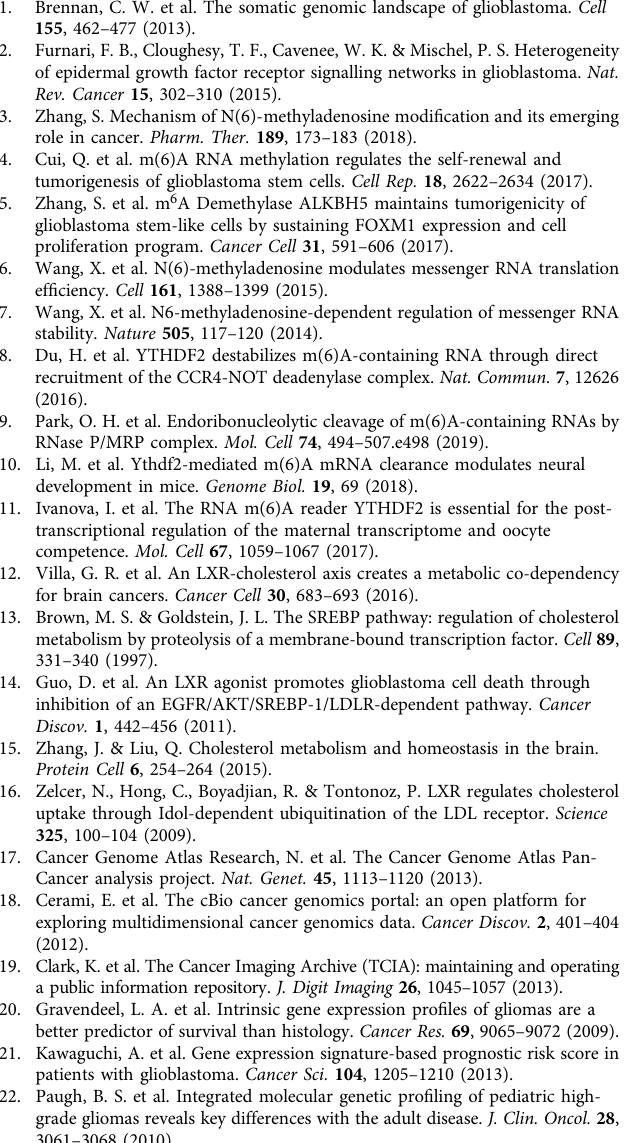
Supplementary Table 1. For luciferase reporter assay, LN229/EGFRvIII tet-on cells (2× 10 4 cells per